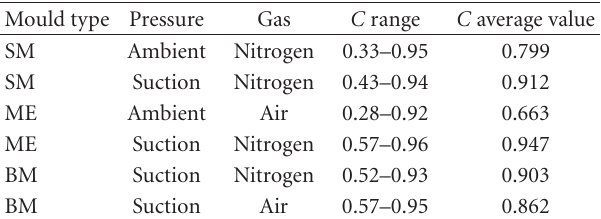
Table 4: Circularity